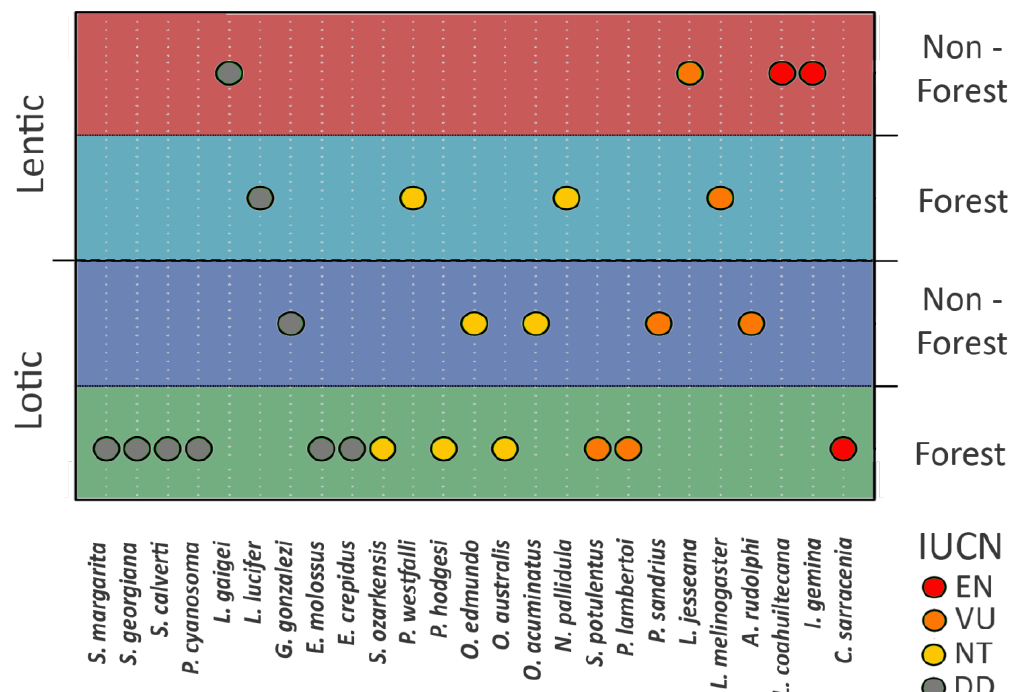
Figure 6. Terrestrial and aquatic habitats of the 24 species categorized as EN (endangered), VU (vulnerable), NT (near-threatened), and DD (data-deficient), according to the IUCN red list.